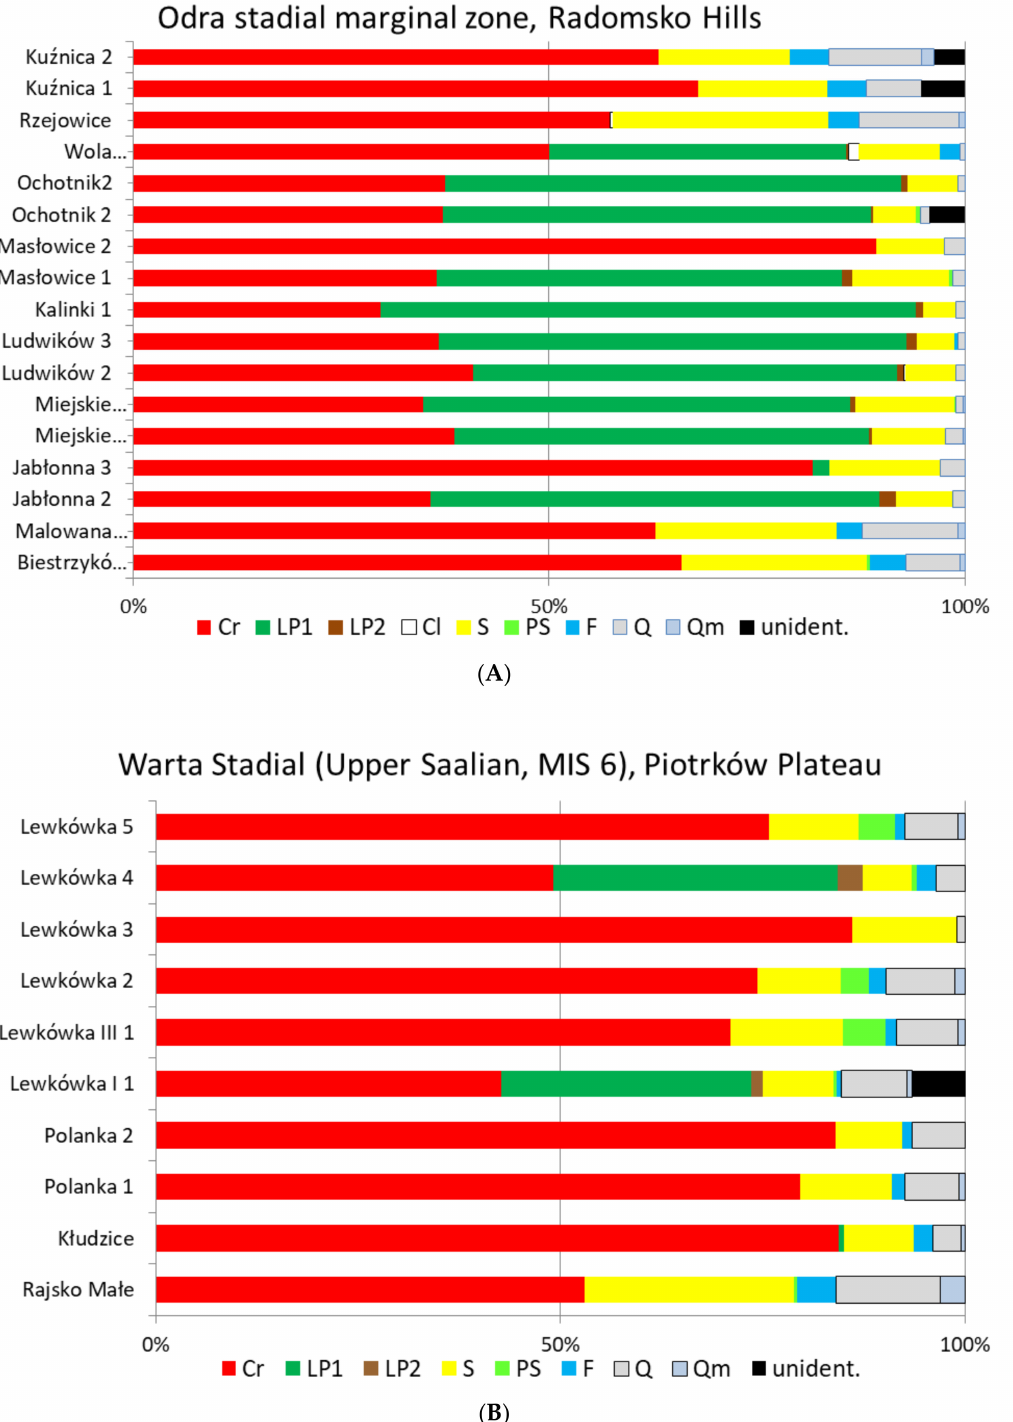
Figure 9. Percentages of the petrographical groups of the glaciofluvial gravels within the marginal zone ( A ) correlated with the Odra Stadial, and its hinterland ( B ) correlated with the Warta Stadial (Upper Saalian, MIS 6). Source: G ó rska-Zabielska and Wachecka-Kotkowska [37]. Symbols explanation: Cr—crystalline, LP1—grey Lower Palaeozoic limestones, LP2—red Lower Palaeozoic limestones, Cl—Cretaceous limestones, S—sandstones, PS—Palaeozoic shales, F—flints, Q—quartz, Qm—milk quartz,